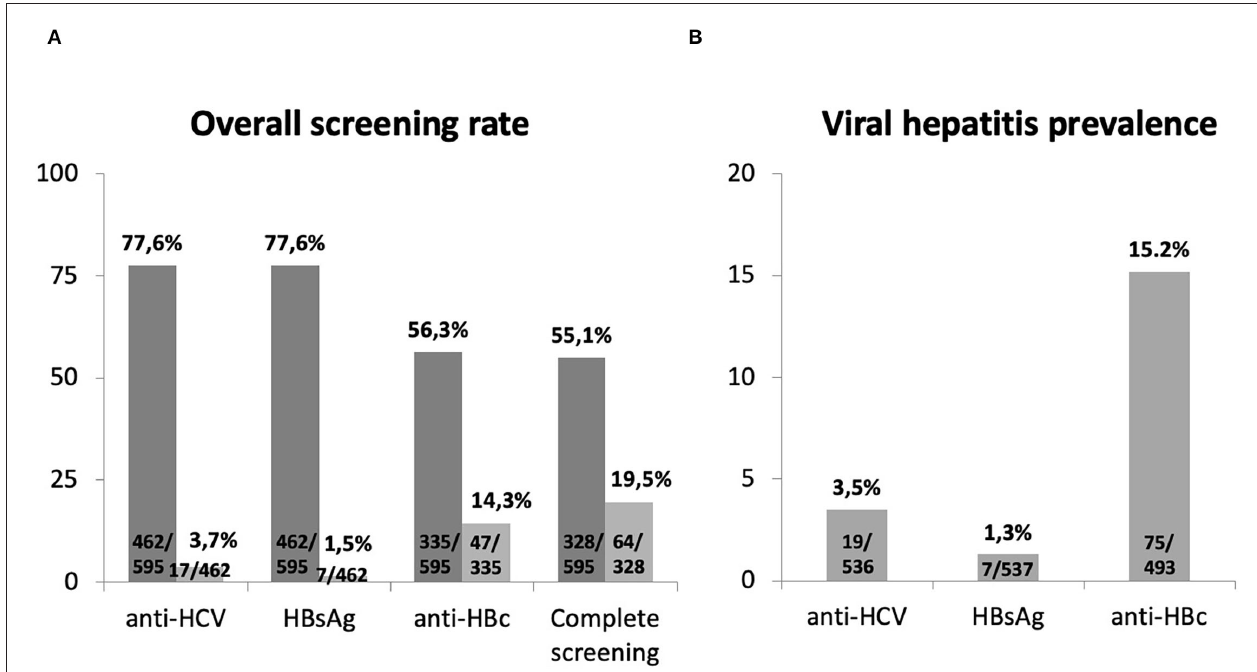
FIGURE 2 | (A) Rate of viral hepatitis markers ordered prior to the beginning of ICIs (dark gray) and the results from these tests (light gray). (B) Overall viral hepatitis prevalence after the prospective request of viral hepatitis markers in alive patients on ICIs. Complete viral hepatitis testing refers to the combination of HBsAg, anti-HBc, and